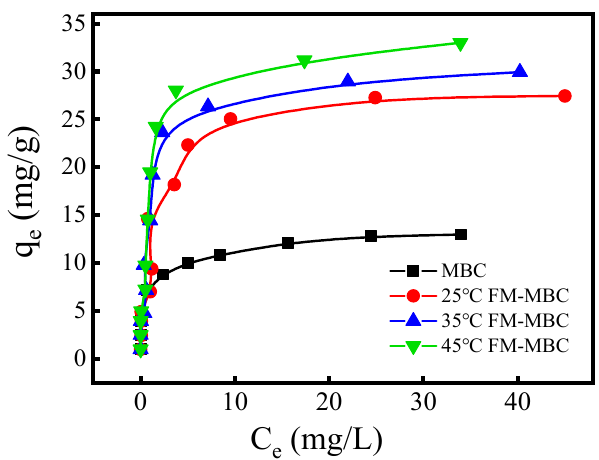
Figure 5. Adsorption isotherms of Cr(VI) adsorption on FM-MBC and MBC.